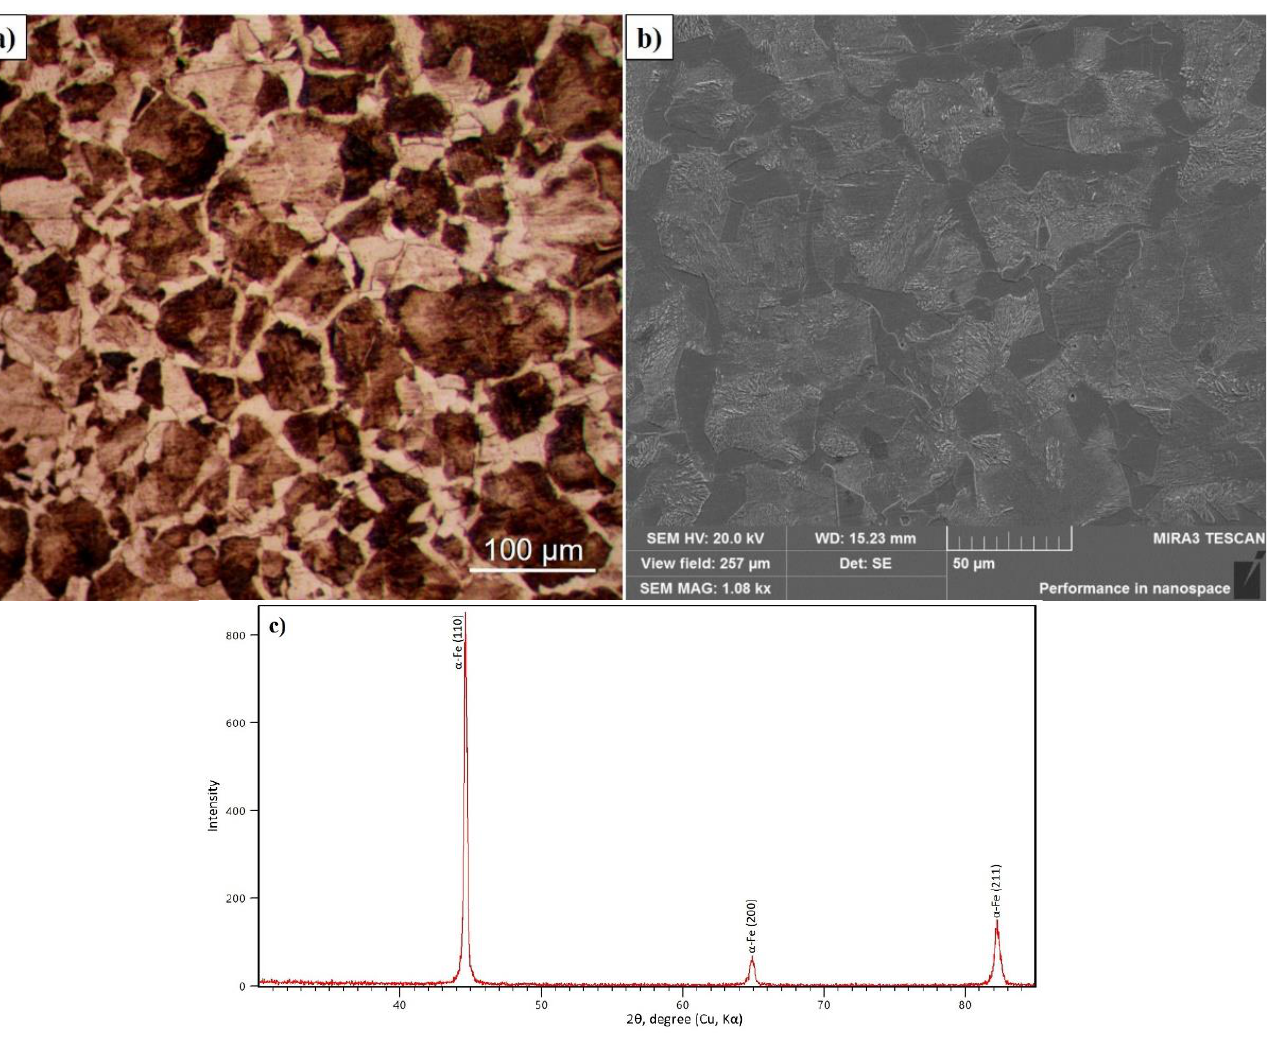
Figure 2. Micrographs of the initial state of 30CrMnSiA steel obtained by optical ( a ) and scanning ( b ) microscopes and its diffractogram ( c ).